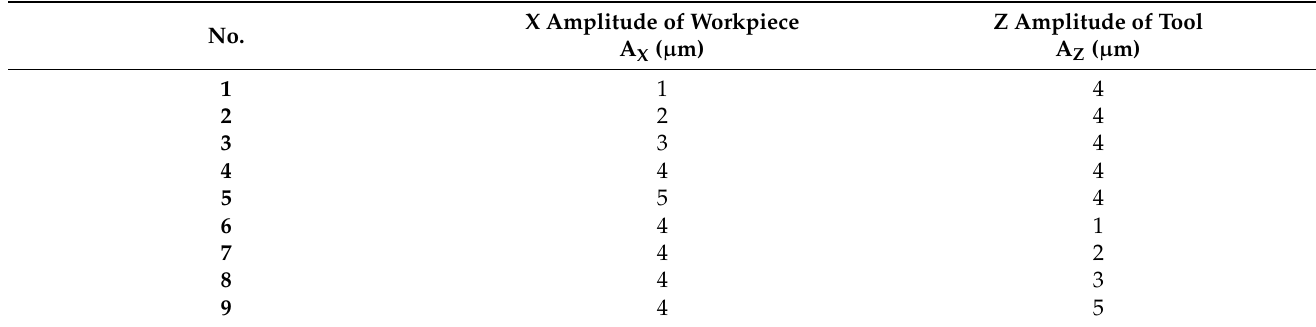
Table 3. The processing test parameters of different